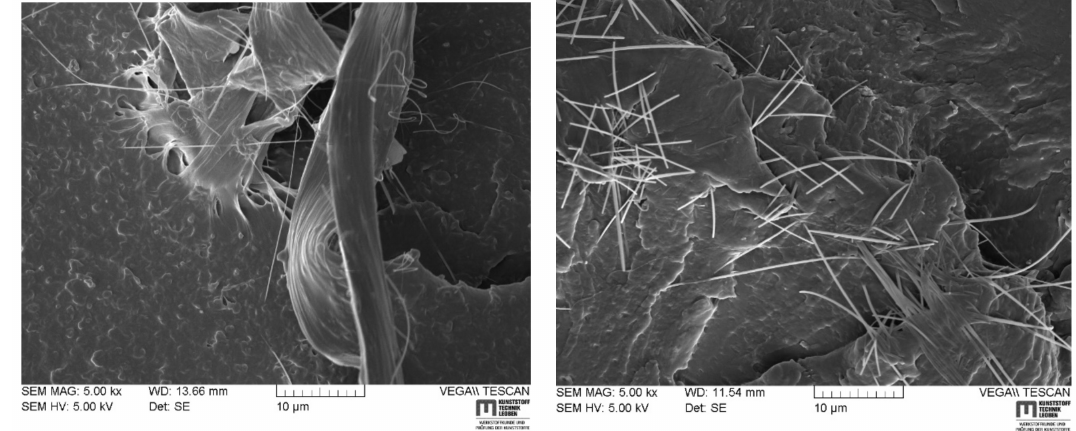
Figure 9. Characteristic macro—(left) and micro-fibrillar (right) structures found in all PA12 grades along the crack path after rapid